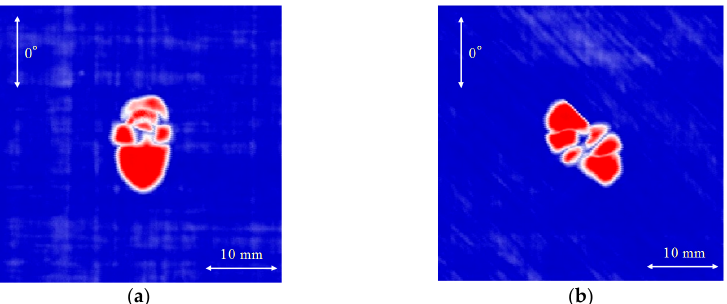
Figure 1. C-scan images depicting impact-induced delamination for carbon fiber reinforced polymer (CFRP) laminates subjected to impact loading with an energy of 6 J. ( a ) [0/90] 2S , ( b ) [0/45/90/ − 45] S .